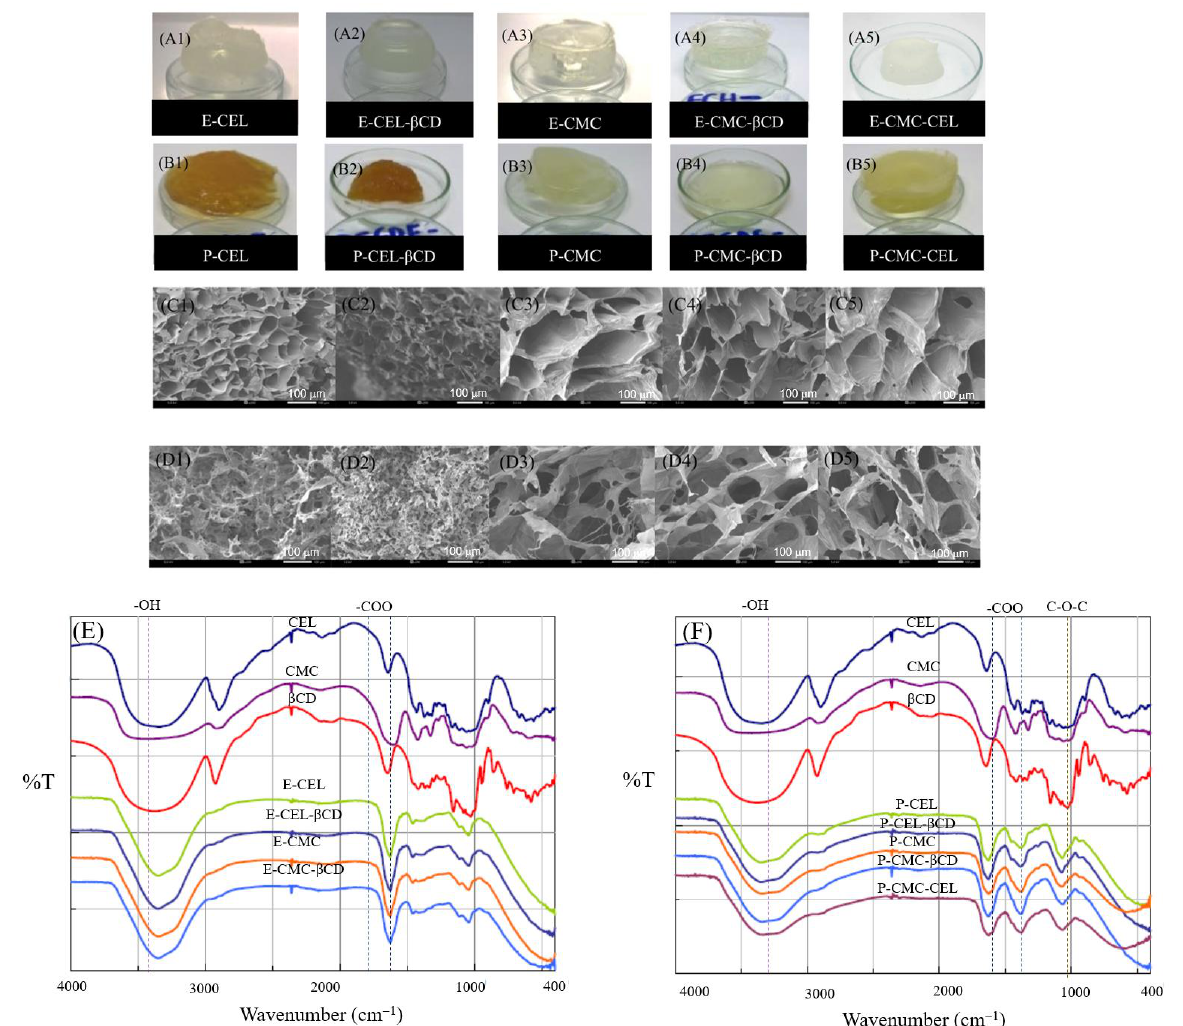
Figure 7. ( A ) The shape of ( A1 ) E-CEL, ( A2 ) E-CEL- β CD, ( A3 ) E-CMC, ( A4 ) E-CMC- β CD, and ( A5 ) E-CMC-CEL gels with ECH as a cross linker; ( B ) The appearance of ( B1 ) P-CEL, ( B2 ) P-CEL- β CD, ( B3 ) P-CMC, ( B4 ) P-CMC- β CD and ( B5 ) P-CMC-CEL gels with PEGDE as a cross linker; and SEM images at × 200 magnification of ( C ) epichlorohydrin crosslinked hydrogels namely ( C1 ) E-CEL, ( C2 ) E-CEL- β CD, ( C3 ) E-CMC, ( C4 ) E-CMC- β CD and ( C5 ) E-CMC-CEL and ( D ) PEGDE crosslinked hydrogels namely ( D1 ) P-CEL, ( D2 ) P-CEL- β CD, ( D3 ) P-CMC, ( D4 ) P-CMC β CD and ( D5 ) P-CMC-CEL; FT-IR spectra of CEL, CEL- β CD, CMC, CMC- β CD and CMC-CEL gels by using ( E ) ECH as a cross linker and ( F ) PEGDE as a cross